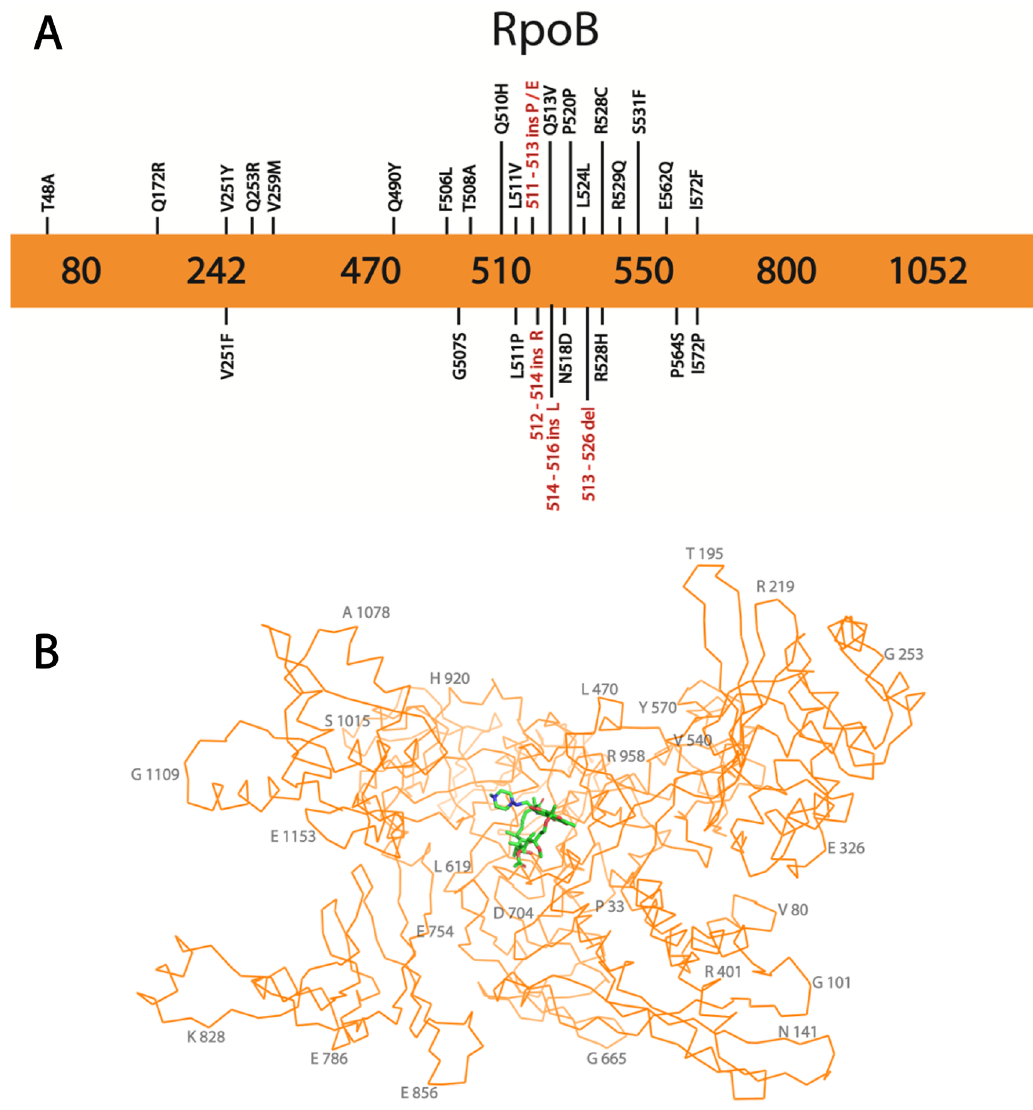
Figure 5 - Structure and key mutations for β-subunit of RNAP encoded by rpoB gene, the main target of RIF and the most reported protein in RIF resistance. A - Representation of β-subunit of RNAP primary sequence in orange, showing the most relevant mutations. Substitutions are shown in black, while insertions and deletions are shown in red. B – The β-subunit of RNAP structure. The representation in orange shows the Cα contours while RIF is shown with carbon atoms in light green. The β-subunit of RNAPR encoded by rpoB was obtained from PDB entry 5UHD (Lin et al ., 2017) and the figure was prepared using the software PyMOL (Schrödinger, 2015). Some residues are numbered in 50% opacity for better